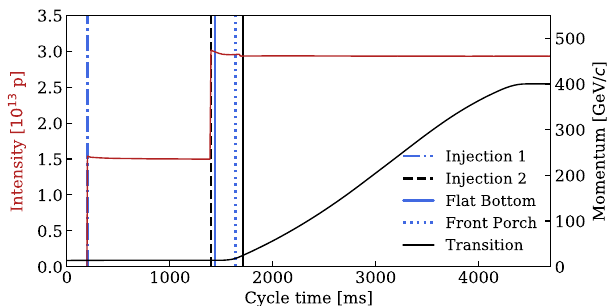
FIG. 14. Example of beam intensity in the SPS as a function of time. The vertical lines indicate the different stages at which the transmission efficiencies are